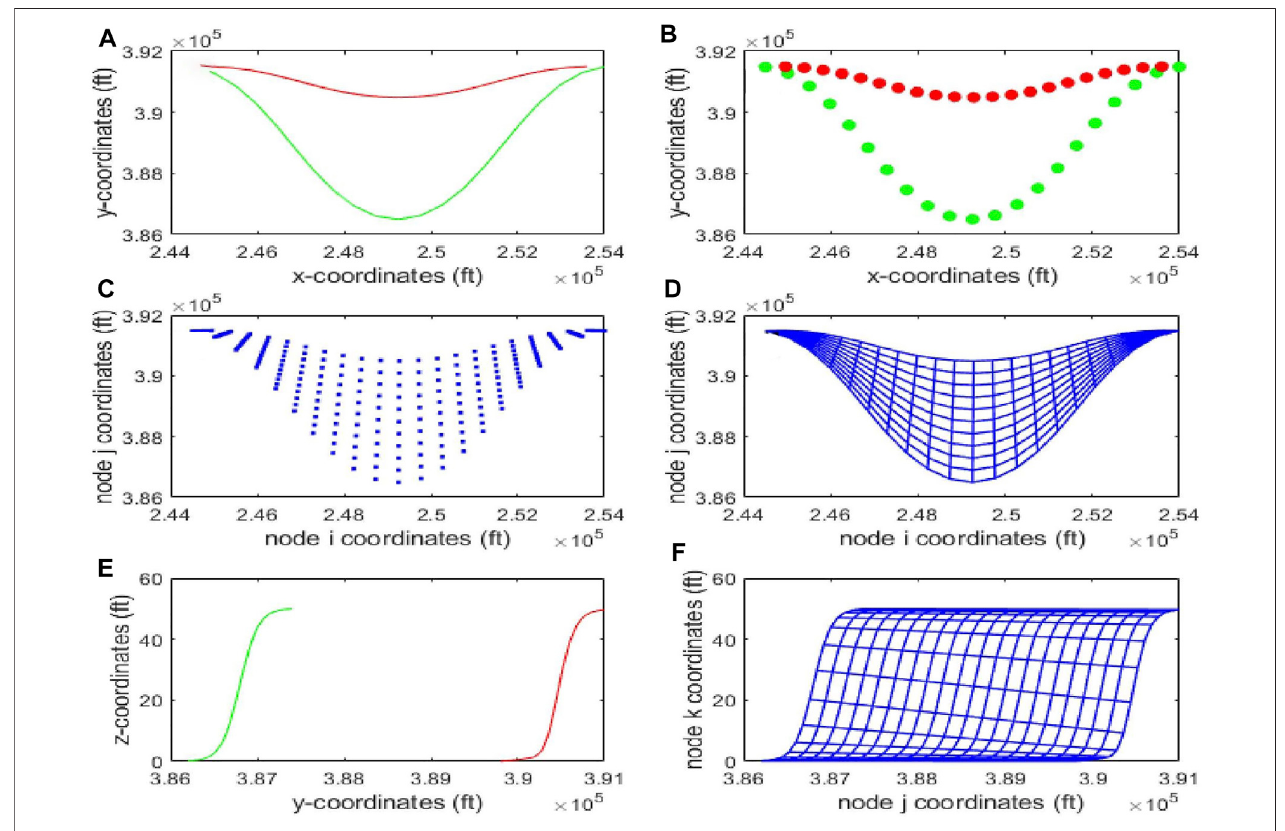
FIGURE5 | Grid generation process: (A) domain tobe gridded for the lateral accretions,bounded bythe initial channel path (red) and current channel path(green), (B) gridnodescomputedalongeachchannelmeanderpath, (C) gridnodescomputedbetweenthechannelmeanders,tocompletethegriddingoflateralaccretions, (D) equivalentcurvilineargridand (F) equivalentcurvilineargridfortheIHS. (E)